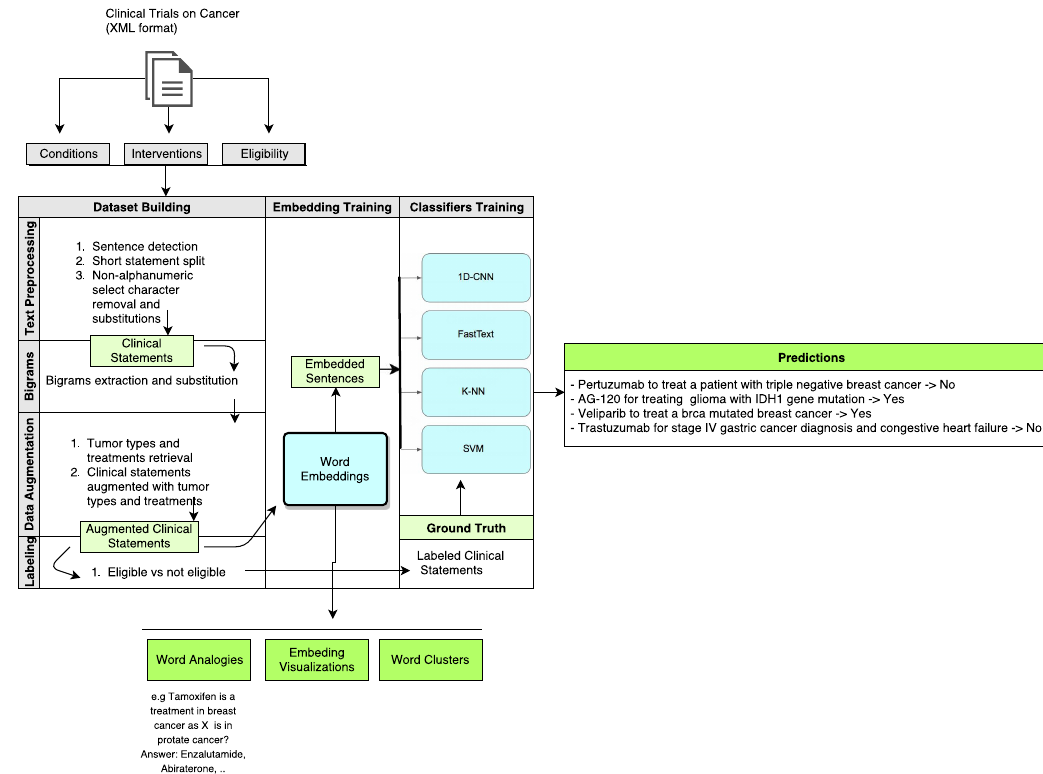
Figure 1. System Architecture: The objective of the final model is to predict whether or not short clinical statements concerning the type of tumor, including the molecular profile, the oncologic treatment, the medical history, or concomitant medication, were included in clinical trials.